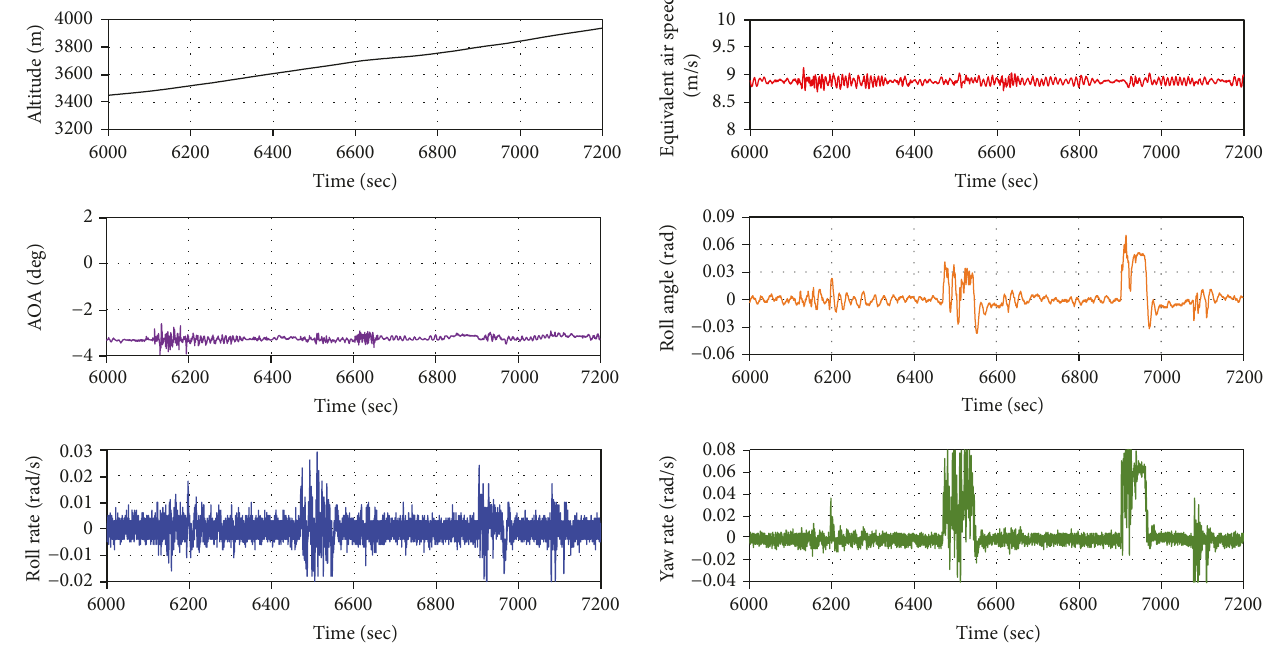
Figure 25: Example of fl ight data (altitude, equivalent air speed, attitude angle, and rate).